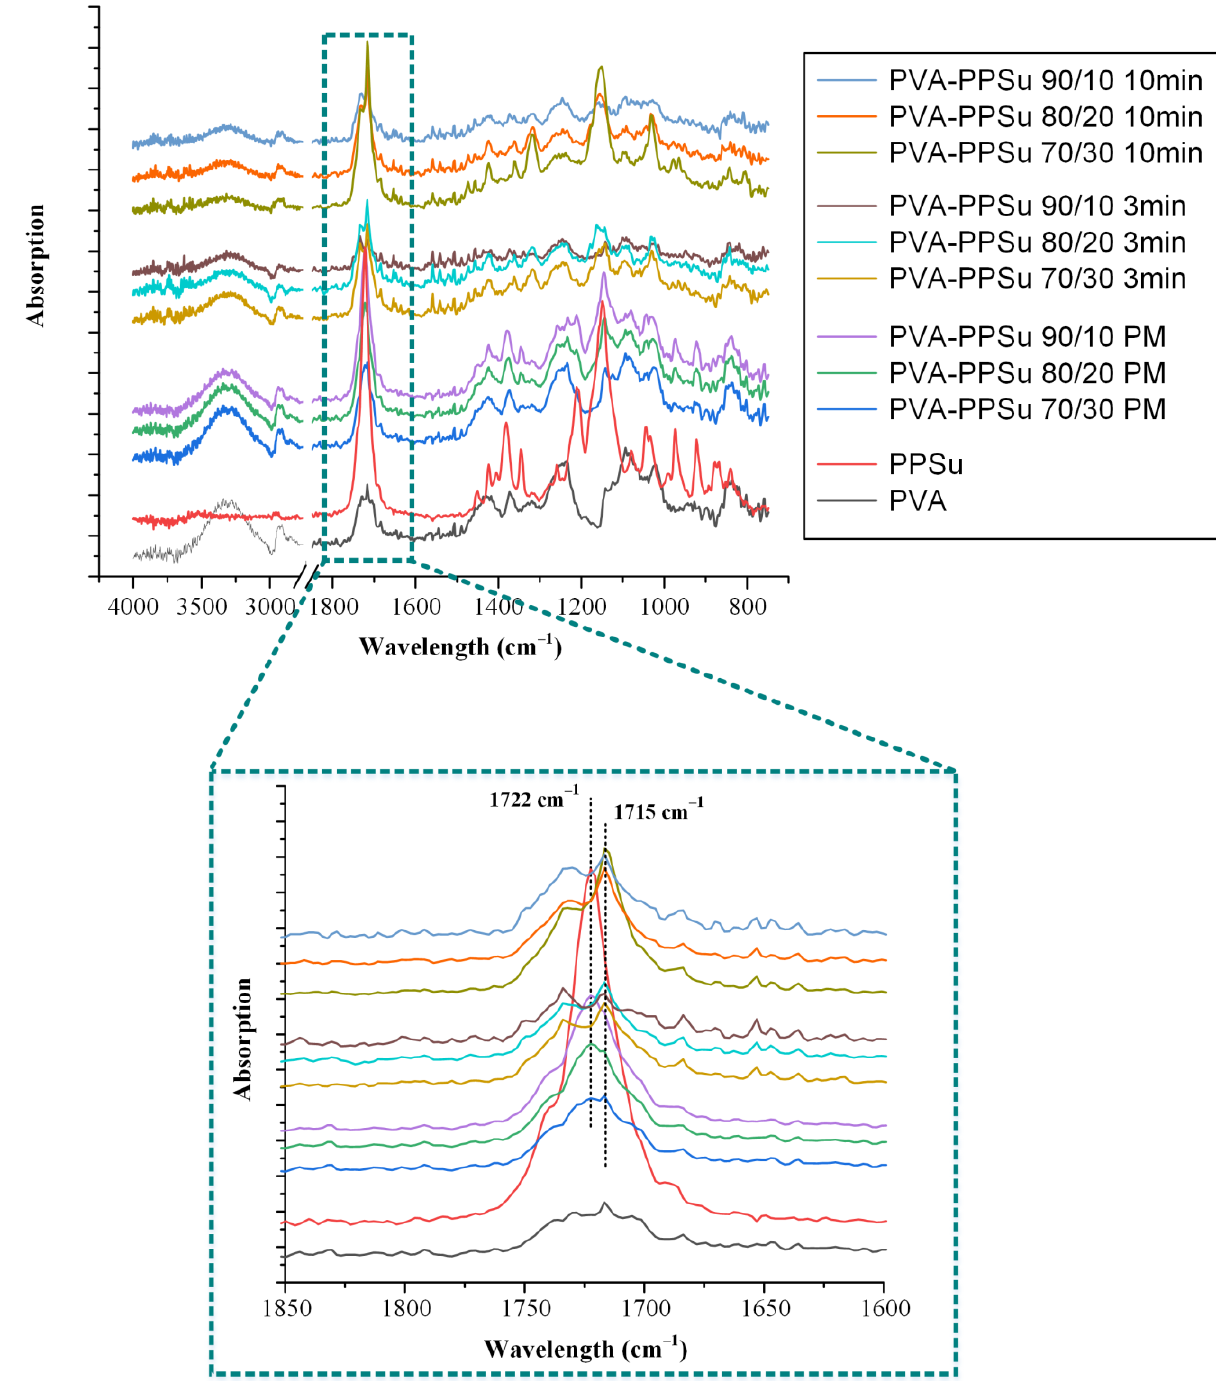
Figure 6. ATR − FTIR spectra of raw materials (PVA and PPSu), their physical mixtures (PMs) and melt − fusion dispersions prepared after 3 and 10 min of melt-mixing.